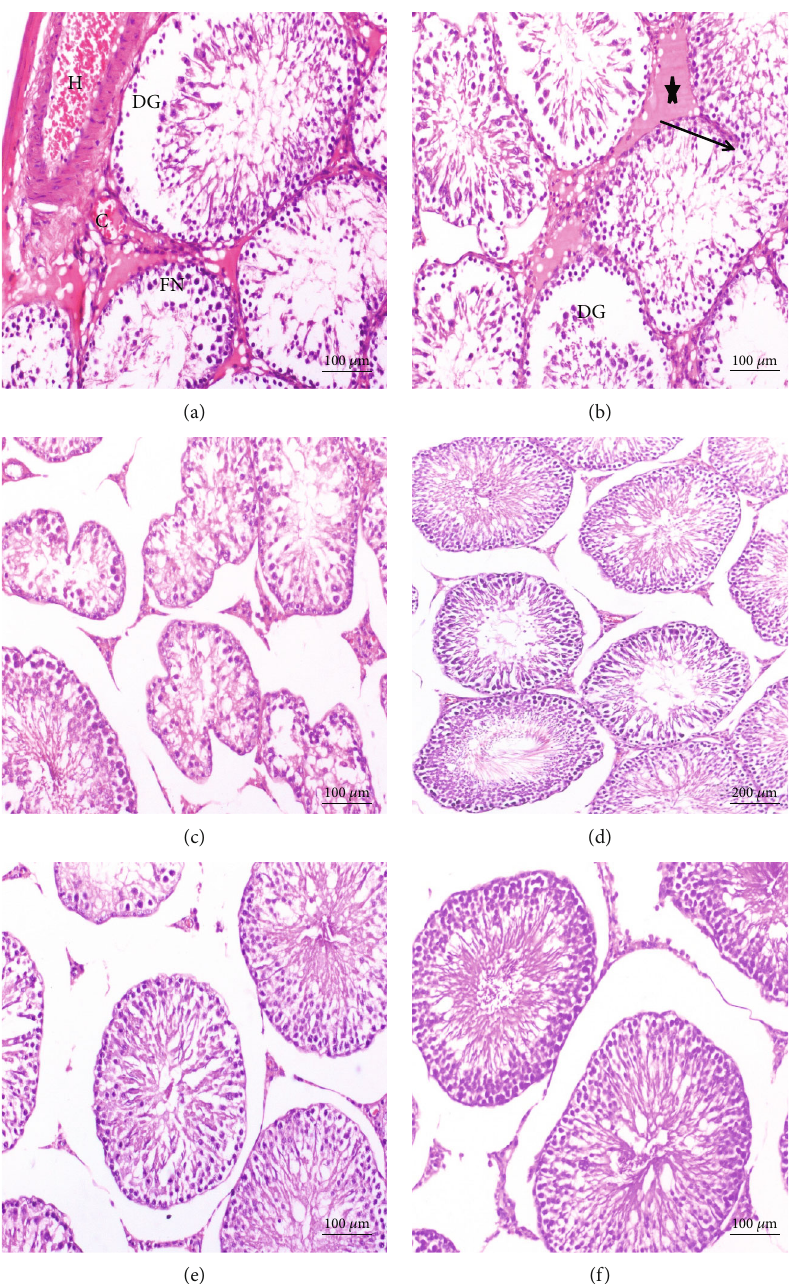
Figure 9: Photomicrographs of rat testis sections. (a) From the RA group showing capillary congestion (C), hemorrhage (H), and focal necrosis in germinal cells (FN). (b) From the RA group showing pyknotic nuclei (thin arrows) of primary spermatocytes (PS), interstitial edema (star), and degeneration of germ cells (DG). (c) From the RA group showing irregular variable-sized seminiferous tubules and atrophy in seminiferous tubules, with most tubules showing a marked decrease in the number of spermatogenic cells; consequently, the lumen of the tubules appeared with few or no sperms observed. (d – f) From arthritic-treated groups with curcumin, stem cells, and a mixture of stem cells and curcumin, respectively, showing a nearly normal histological structure of the seminiferous tubules